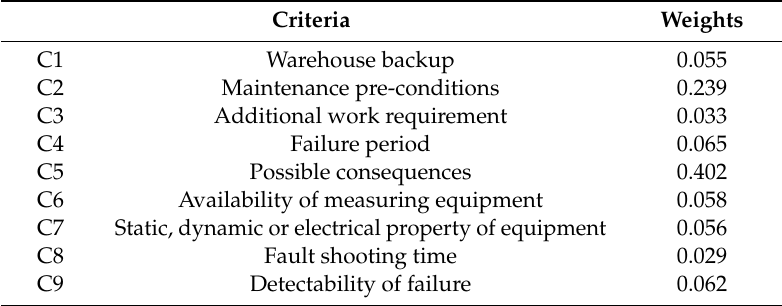
Table 6. Criteria